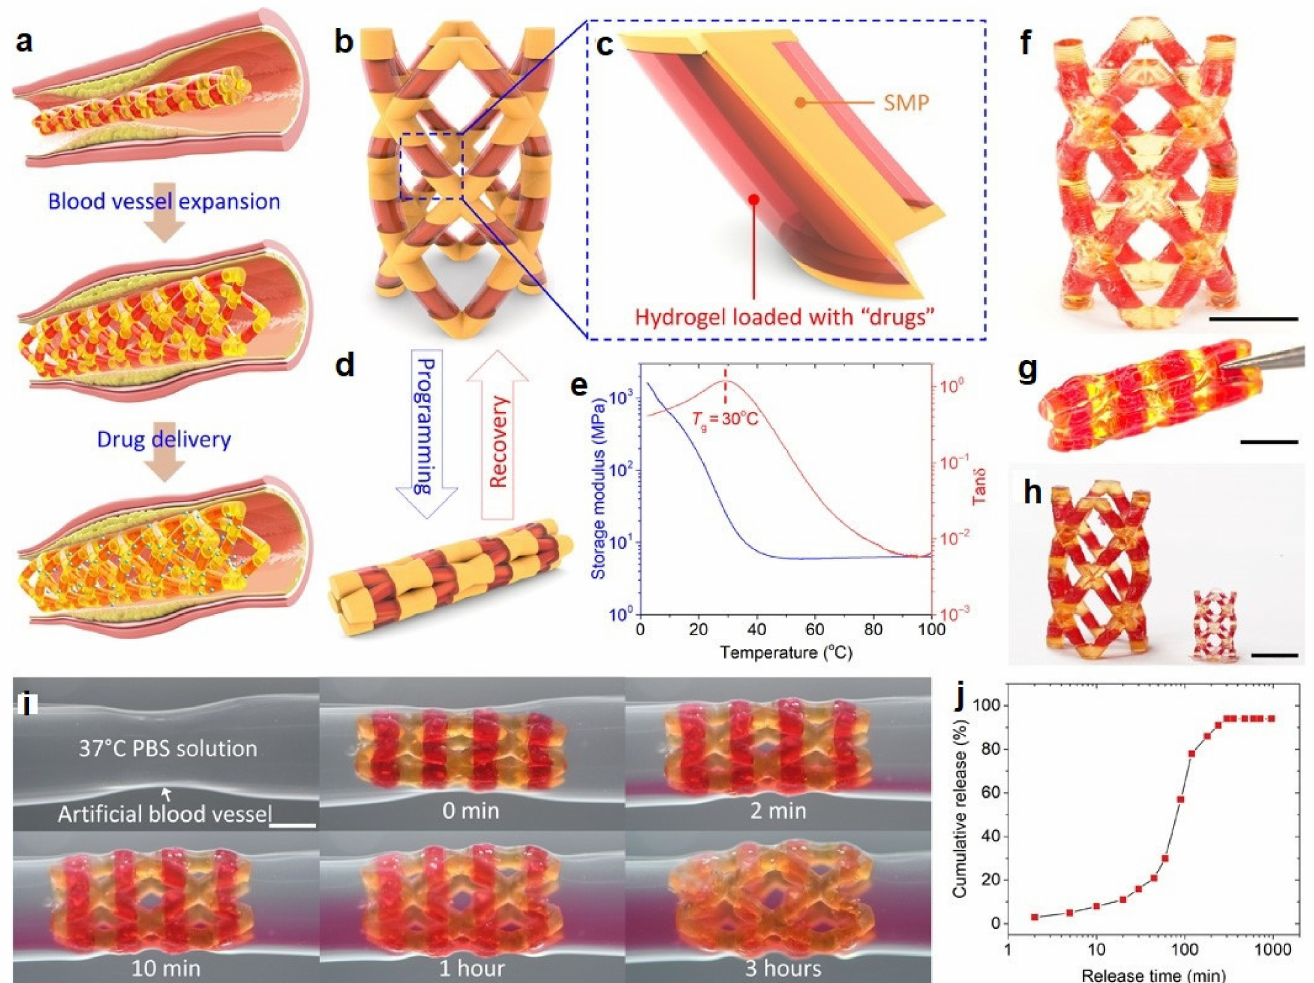
Figure 12. ( a ) Demonstration of blood vessel interaction with the 3D printed SMP-hydrogel stent and drug release profiles. ( b ) Overall design of the SMP-hydrogel stent. ( c ) The SMP rod is wrapped by a drug-loaded hydrogel skin, as shown in the detailed design. ( d ) SMP-hydrogel programmed to a compacted shape demonstration. ( d ) Illustration of the SMP-hydrogel programmed to a compacted shape. ( e ) DMA result indicates that the T g of the SMP used to print the stent is 30 ◦ C. ( f – h ) Snapshots of printed SMP-hydrogel stents. ( f ) As-printed SMP-hydrogel stent. ( g ) SMP-hydrogel stent in